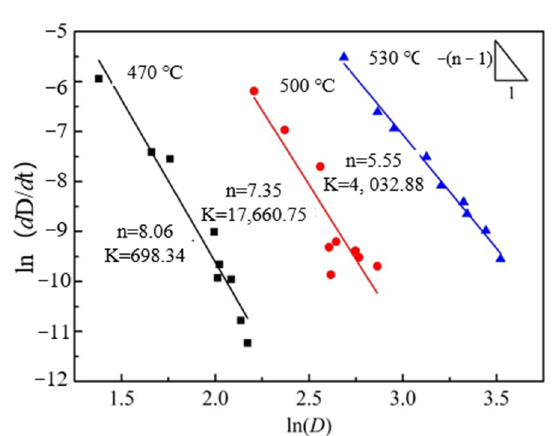
Figure 8. Relationship of the logarithm of (d D /d t ) vs. the logarithm of D .